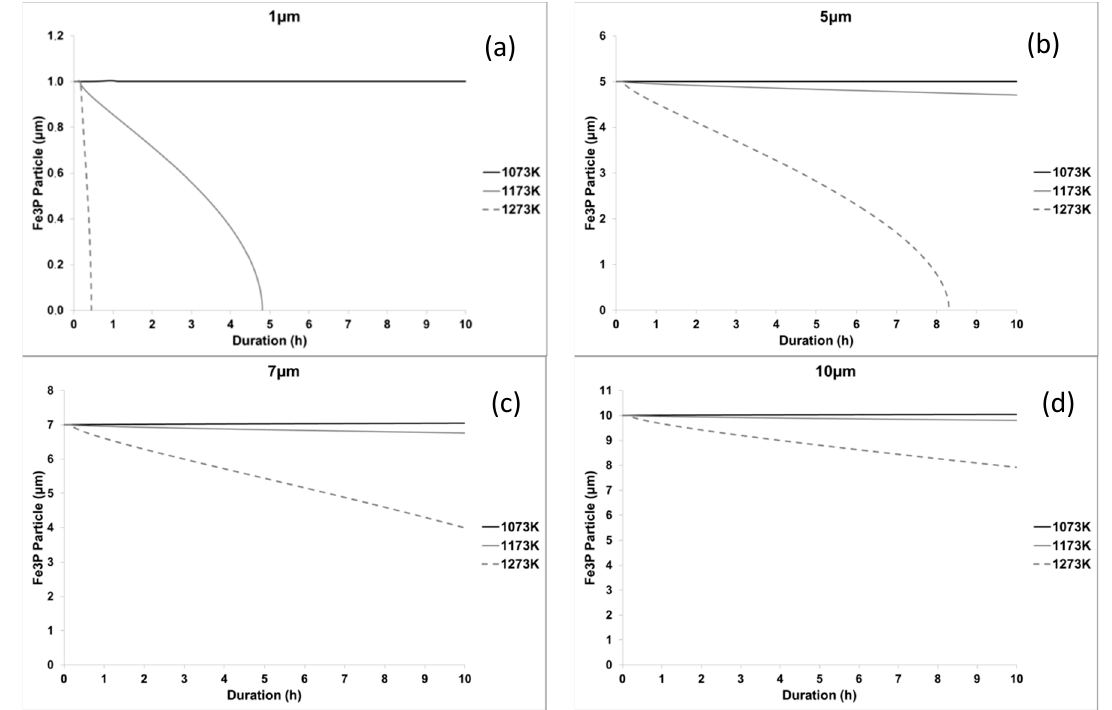
Figure 5. Simulation results of homogenization of Fe 3 P particles in the Cu matrix tested at various temperatures for ( a ) 1 µ m, ( b ) 5 µ m, ( c ) 7 µ m, ( d ) 10 µ m.